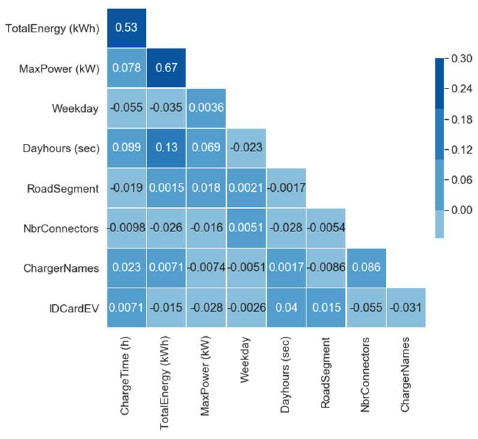
Figure 3. Correlation matrix of input variables.